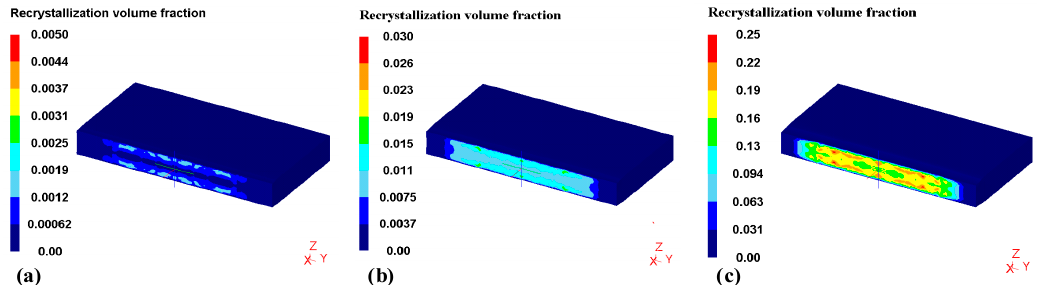
Figure 11. Volume fraction of DRX after HHR 2 with distinct reduction amounts: ( a ) 20mm; ( b ) 30 mm; ( c ) 50 mm.